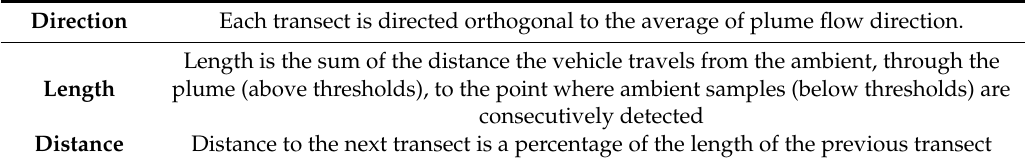
Table 13. Three features of the proposed adaptive transect mapping